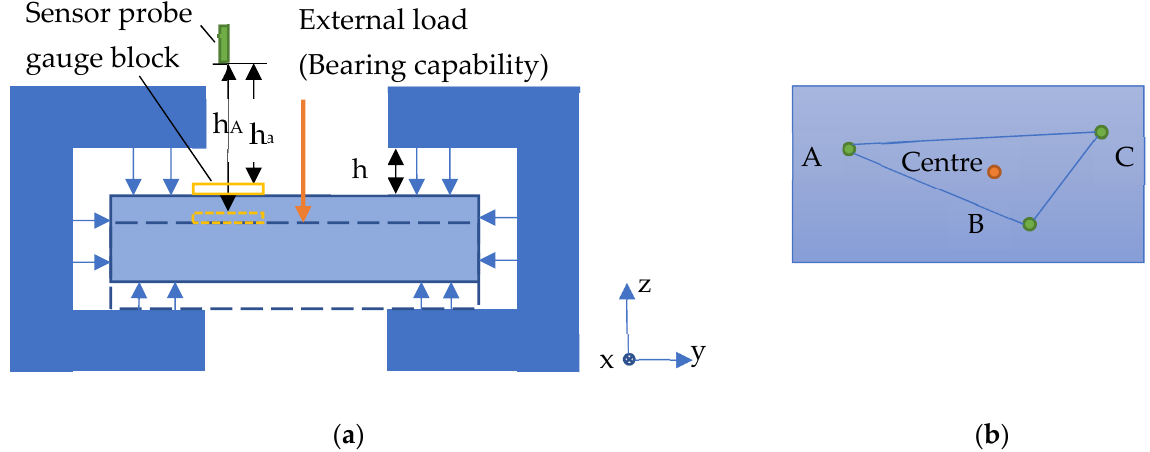
Figure 15. Schematic diagram for the bearing capacity measurement experiment. ( a ) The bearing capacity changes the thickness of an air film; and ( b ) the method for determining the thickness of an air film.